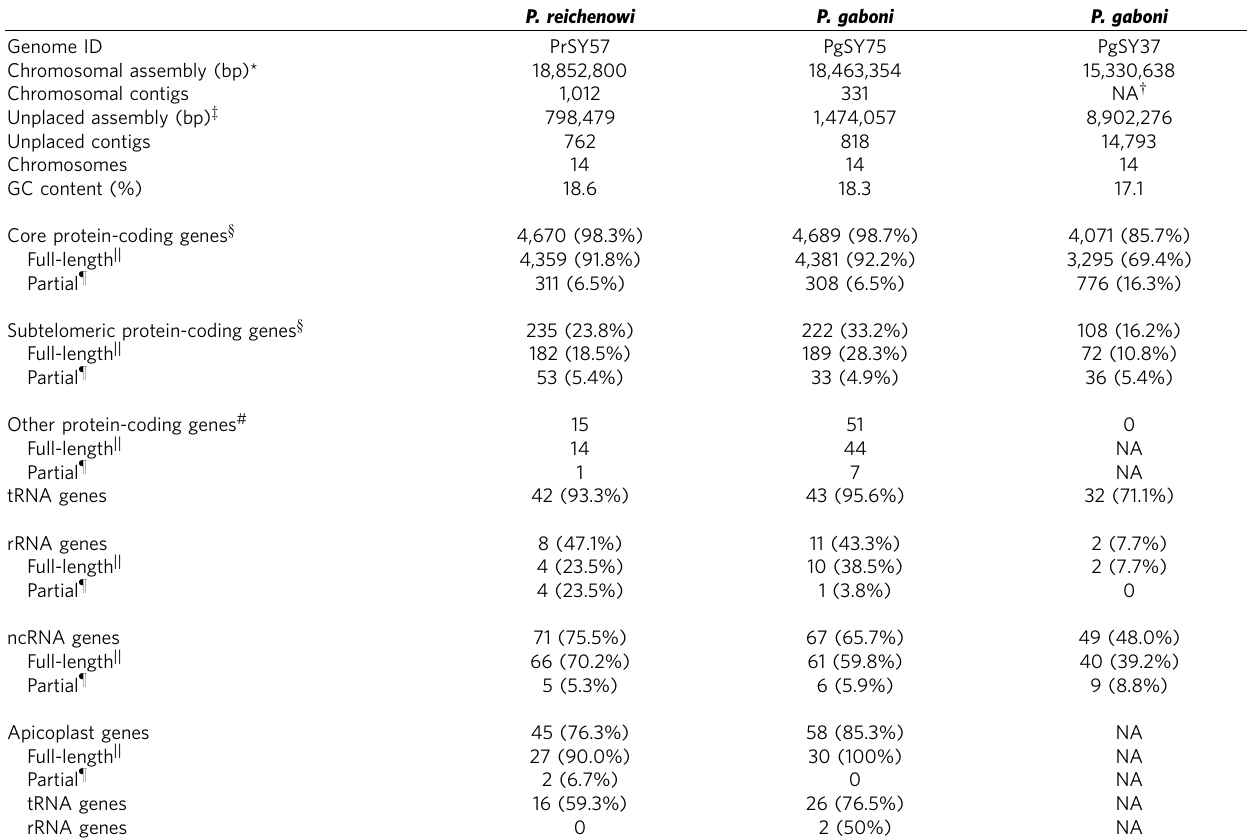
Table 2 | Genome features of P. gaboni and P. reichenowi